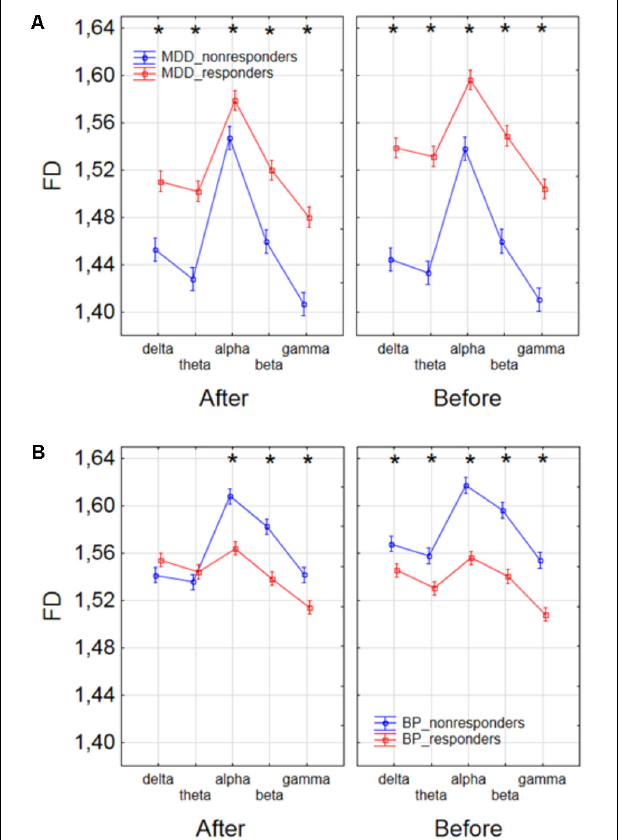
FIGURE 6 | Comparison of FD value between MDD_non-responders and MDD_responders groups (A) and between BP_non-responders and BP_responders groups (B) in each frequency band separately, for condition before and after session. The interaction between factors CONDITION, BAND, and GROUP (comparison between responders and non-responders separately in groups of MDD and BP patients). Significant differences between both groups for the individual frequency bands and conditions, evaluated by post hoc Tukey HSD test, were marked with asterisks.